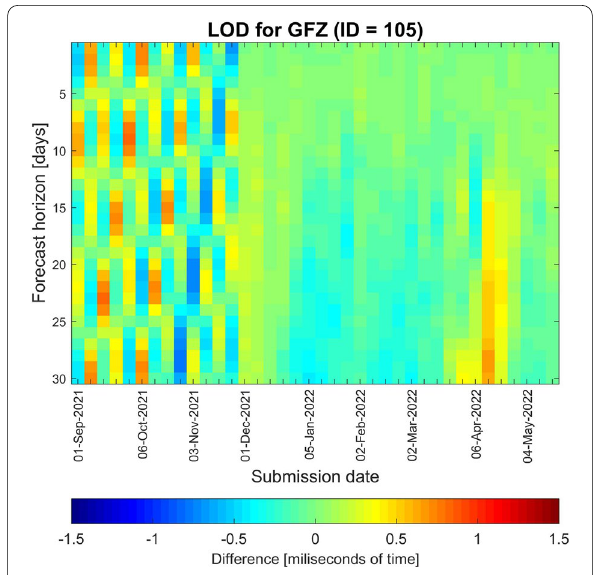
Fig. 3 Differences of individual LOD predictions from GFZ (ID against the 14 C04 solution. Oscillatory patterns with periods of 14 days are related to long-periodic ocean tides that were not properly accounted for before December 1st, 2021 (MJD